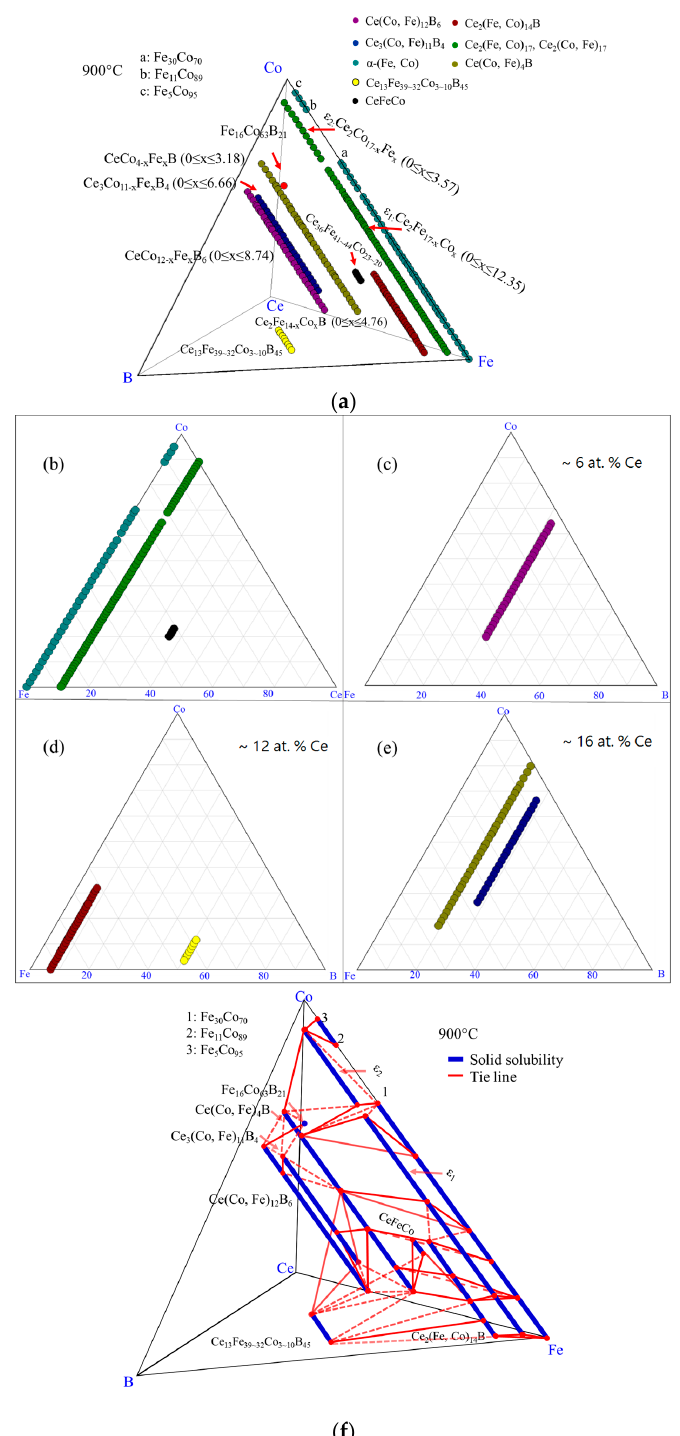
Figure 23. Combined experimental results of diffusion couples and key alloys in the Ce-Fe-Co-B system at 900 ◦ C: ( a ) 3D presentation of the experimental results; ( b ) Fe-Ce-Co ternary system; ( c ) pseudo ternary section at ~6 at. % Ce; ( d ) pseudo ternary section at ~12 at. % Ce; ( e ) pseudo ternary section at ~16 at. % Ce; ( f ) phase relations in the Fe-rich region of the Ce-Fe-Co-B system at 900 ◦